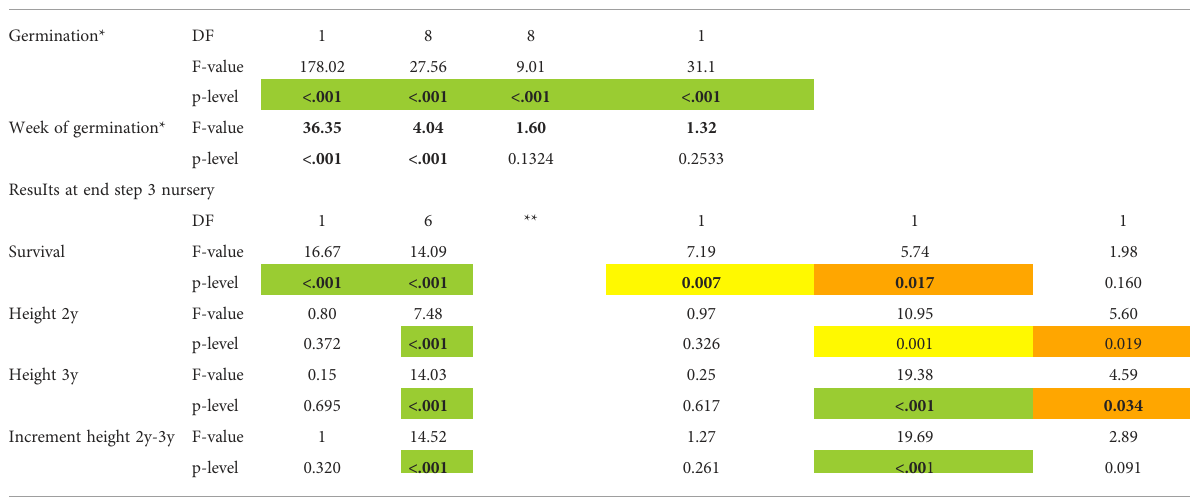
TABLE 3 Results from analyses of covariance for germination success, survival at the end of year 3 in the nursery, height after 2 and 3 years in the nursery and increments from previous year.